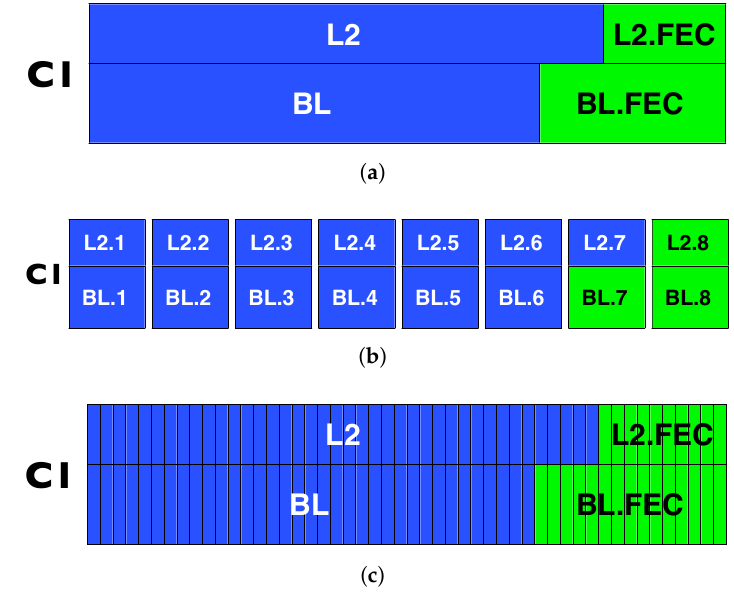
Figure 8. Examples of two layers allocated to class one ( C 1 ) for ( a ) SVC plus FEC and ( b ) description-based models plus FEC; ( b ) illustrates the section structure of MDC utilised by IRP, while ( c ) illustrates an example of the IRP packetisation of the SVC class in ( a